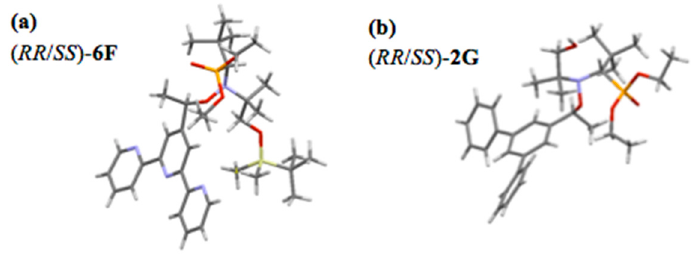
Figure 3. Ortep drawing from X-ray analysis of ( a ) ( RR / SS )- 6F (Figure 3a) and ( b ) ( RR / SS )- 2G .